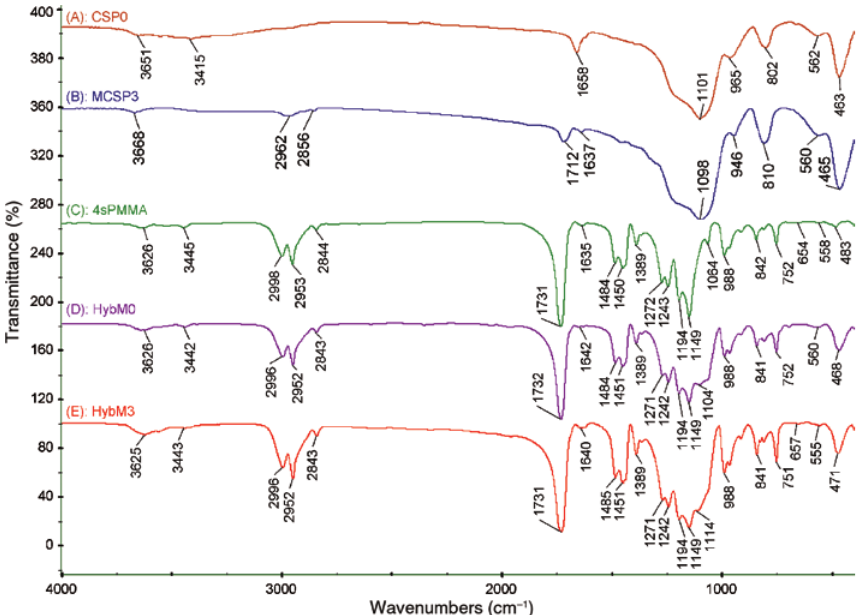
Figure 1: FTIR spectra of (A) unmodified CSPs (CSP0), (B) modified CSPs (MCSP3), (C) neat 4sPMMA and (D, E) hybrid nanocomposites (D: HybM0 (4sPMMA/(PMMA/CSP0)); E: HybM3 (4sPMMA/PMMA grafted